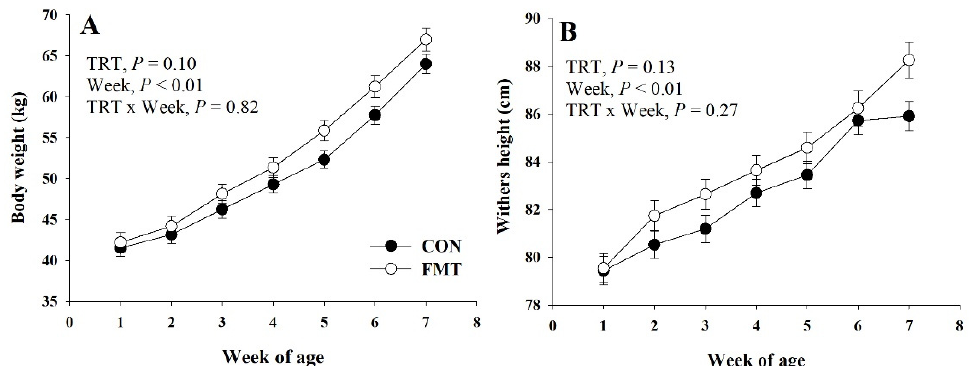
Figure 1. Body weight ( A ) and withers height ( B ) from birth (week 1 of age) to weaning (7 weeks of age) of Holstein dairy calves raised under a conventional nutritional program (CON) or subjected to fecal microbiota transplantation (FMT). The p -values for main effects of treatment (TRT) and week, and their interaction (TRT × Week) are shown in each plot. Values are means with standard errors represented by vertical bars.